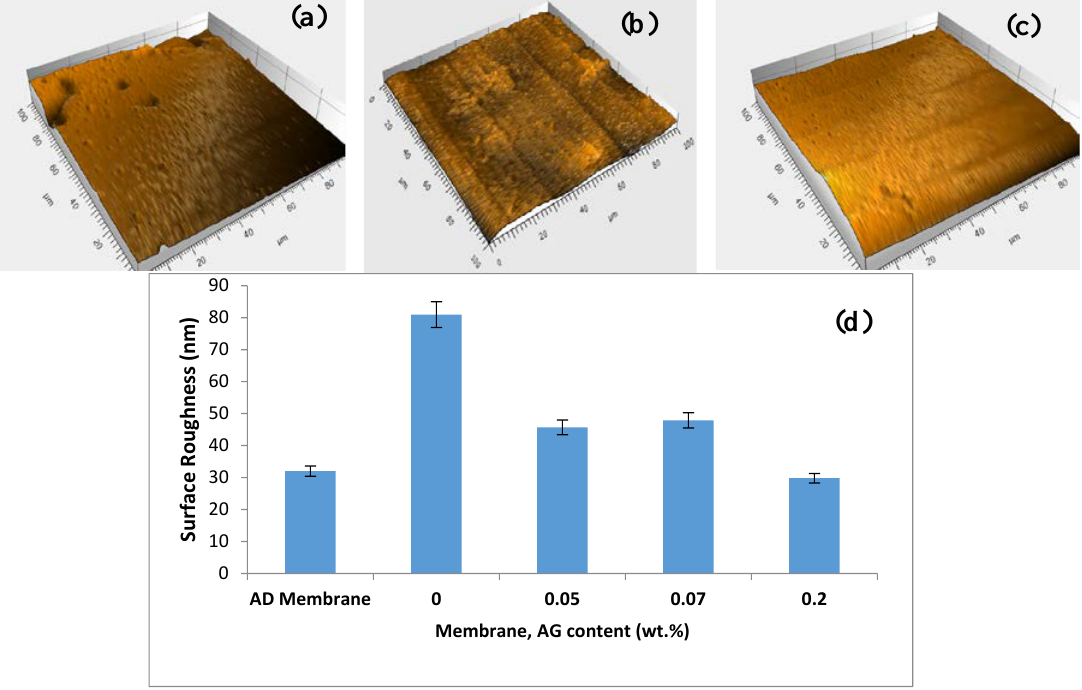
Figure 6. 3D images depicting the membrane surfaces: AD commercial membrane (Osmonics) ( a ), neat PA membrane ( b ), PA/0.1 wt.% AG ( c ) and average surface roughness of the studied membranes ( d ). Scanned area 100 × 100 μm 2 .